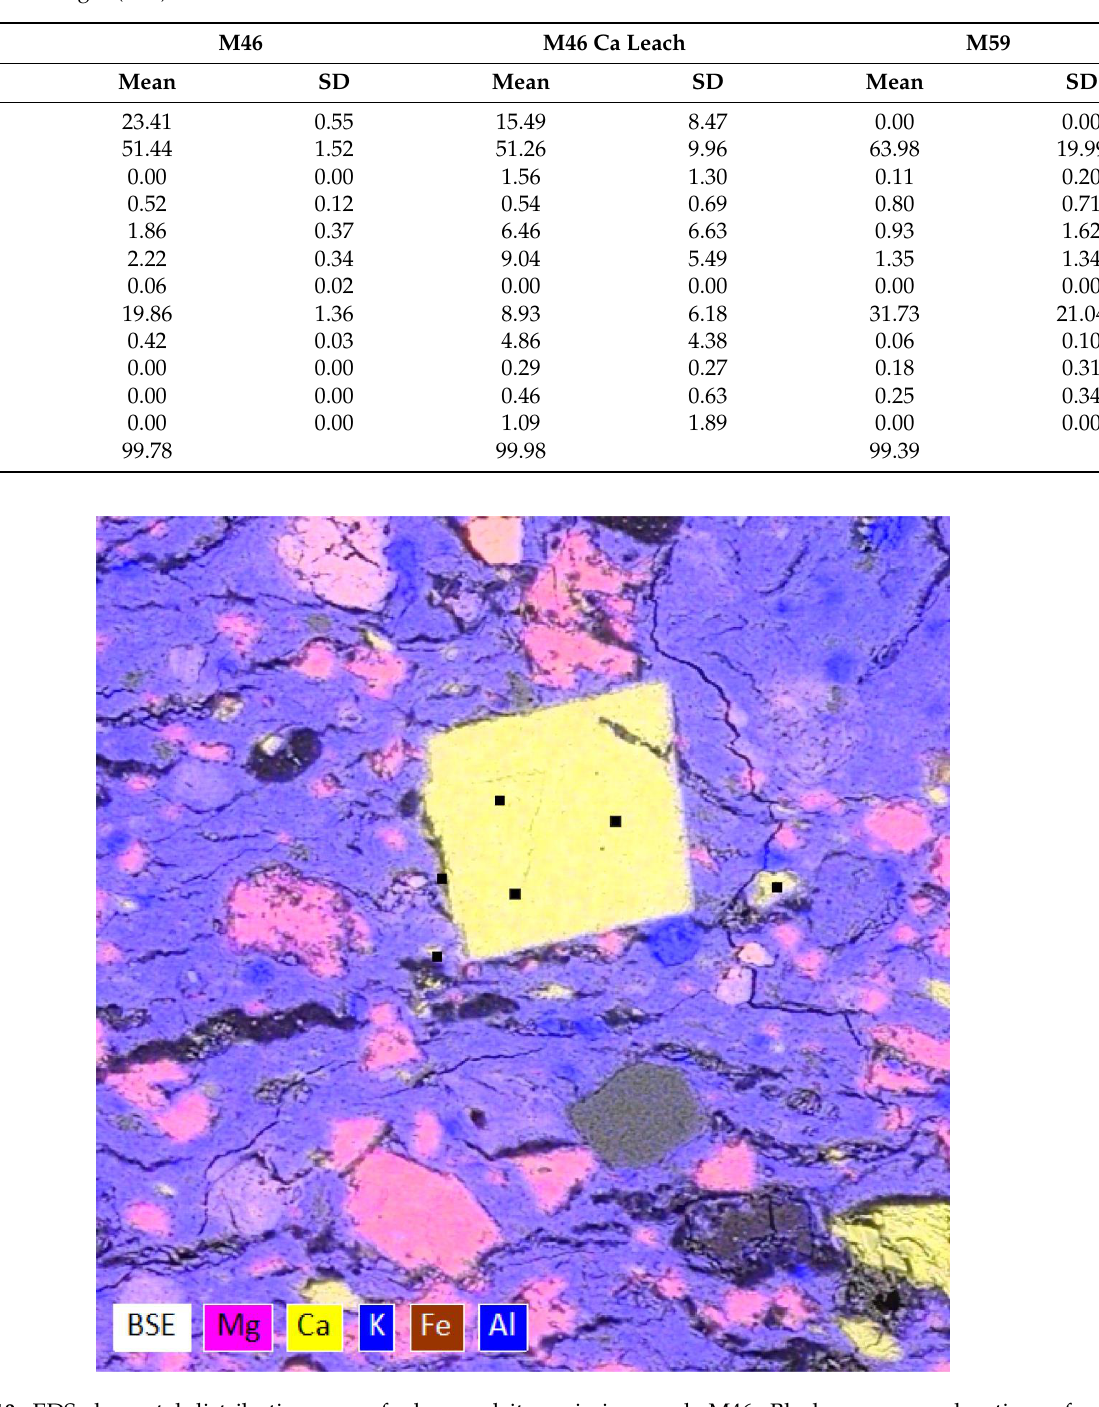
Table 2. Mean EDS elemental concentrations for assumed calcite grains and Ca leaching in M46 and M59. Data expressed in atomic percentages (at%).